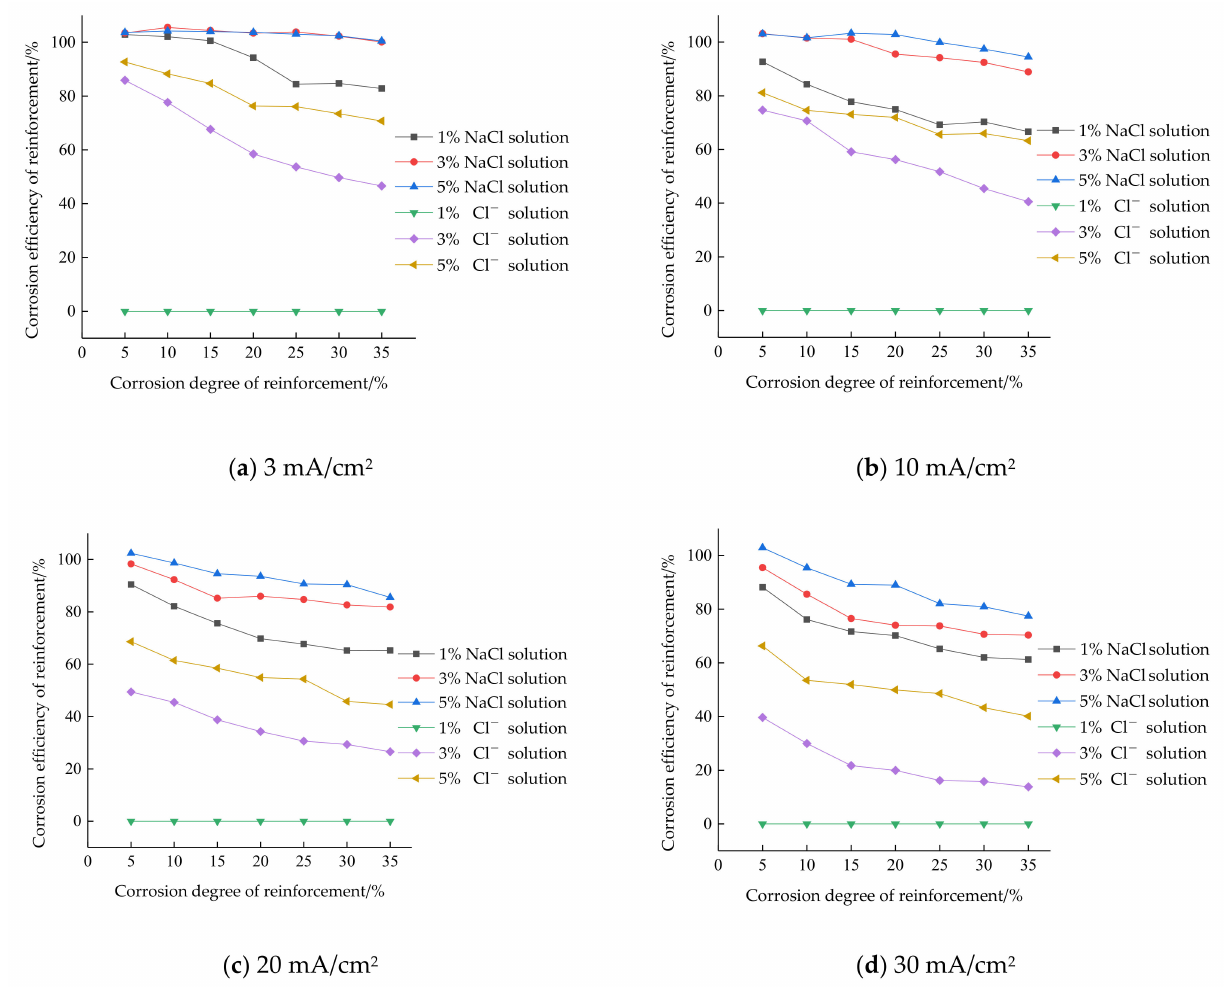
Figure 3. The corrosion efficiency of reinforcement under different current densities and solution environments. ( a ) The corrosion efficiency of reinforcement under 3 mA/cm 2 current densities; ( b ) The corrosion efficiency of reinforcement under 10 mA/cm 2 current densities; ( c ) The corrosion efficiency of reinforcement under 20 mA/cm 2 current densities; ( d ) The corrosion efficiency of reinforcement under 30 mA/cm 2 current